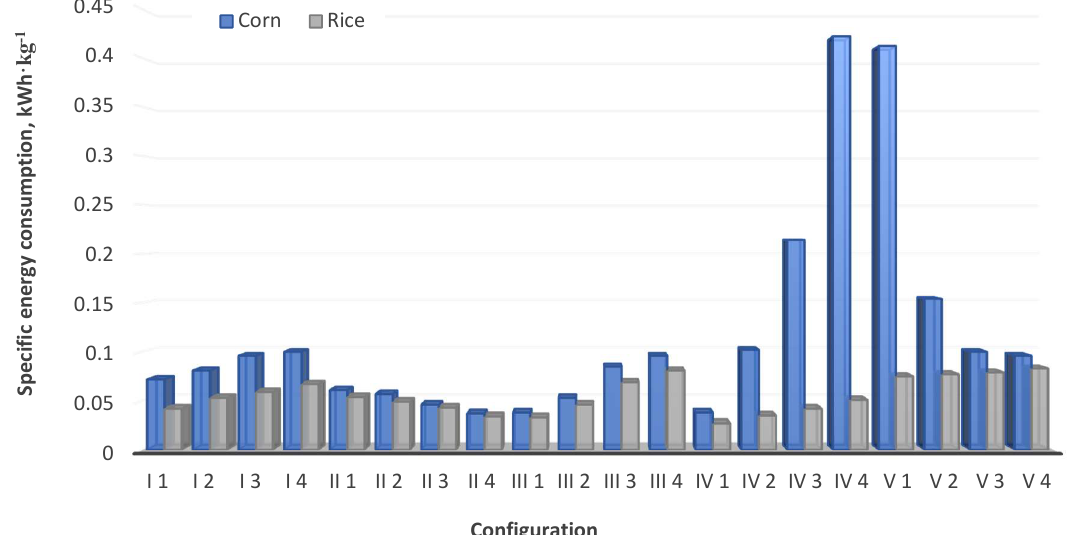
Figure 7. Test results of the unit energy consumption for rice and corn grinding.